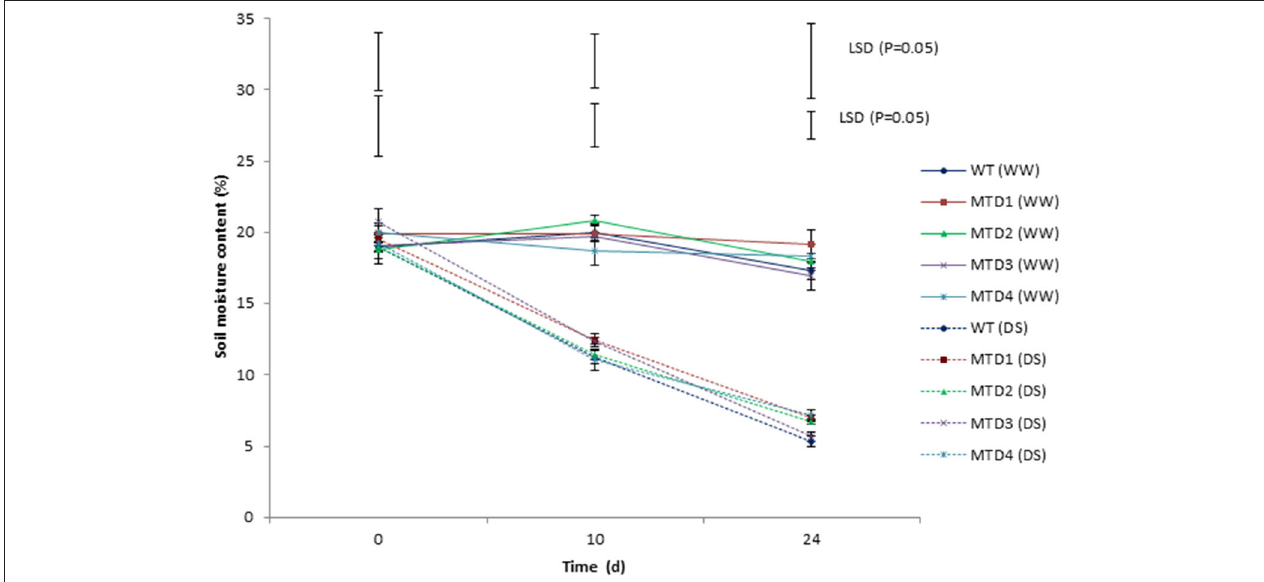
FIGURE 3 | Comparison of soil-moisture content at 30 and 45 cm depths at 0, 10, and 24 days under well-watered and drought-stress conditions in wild-type and transgenic lines. Where, error bars on the line are SEM, while those on top represent LSD (0.05)